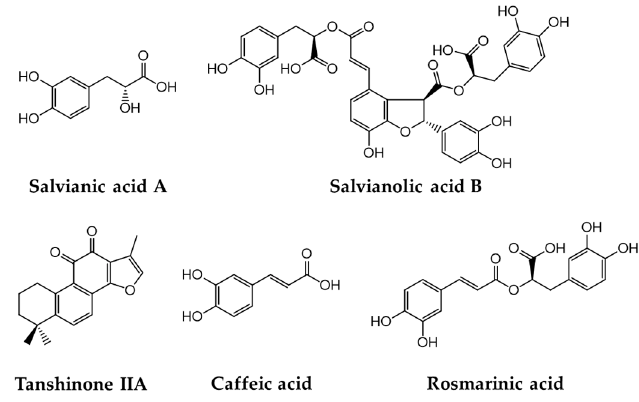
Figure 1. Five bioactive marker compounds found in Salviae miltiorrhizae Radix.